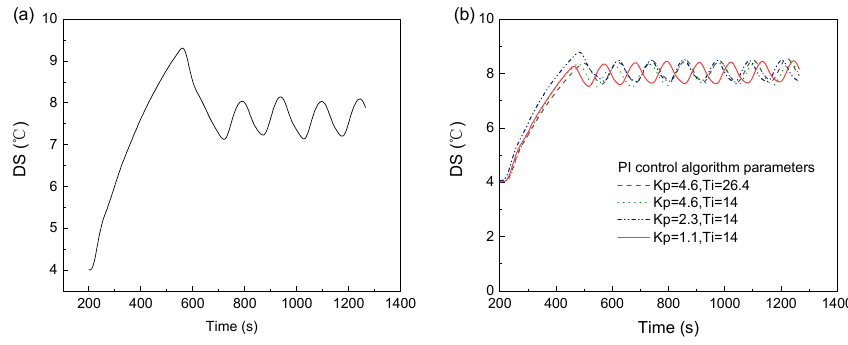
Figure 10. Response curves of PI cnotrol: ( a ) EXV1; ( b ) PI control parameters optimization.